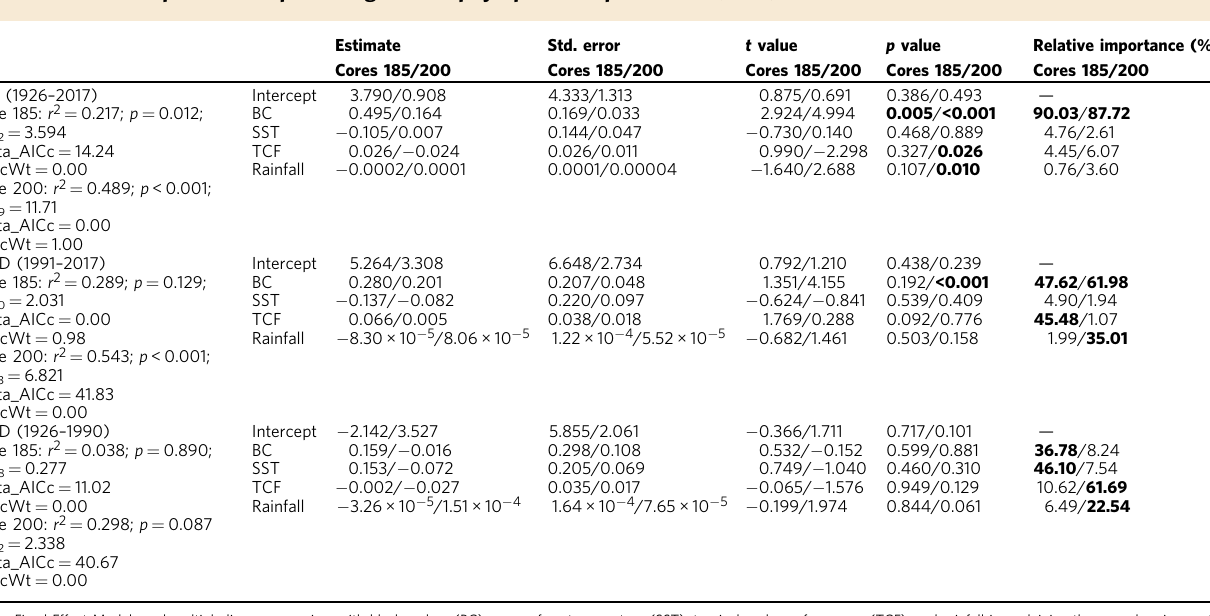
Table 2 Relative importance in predicting marine phytoplankton production